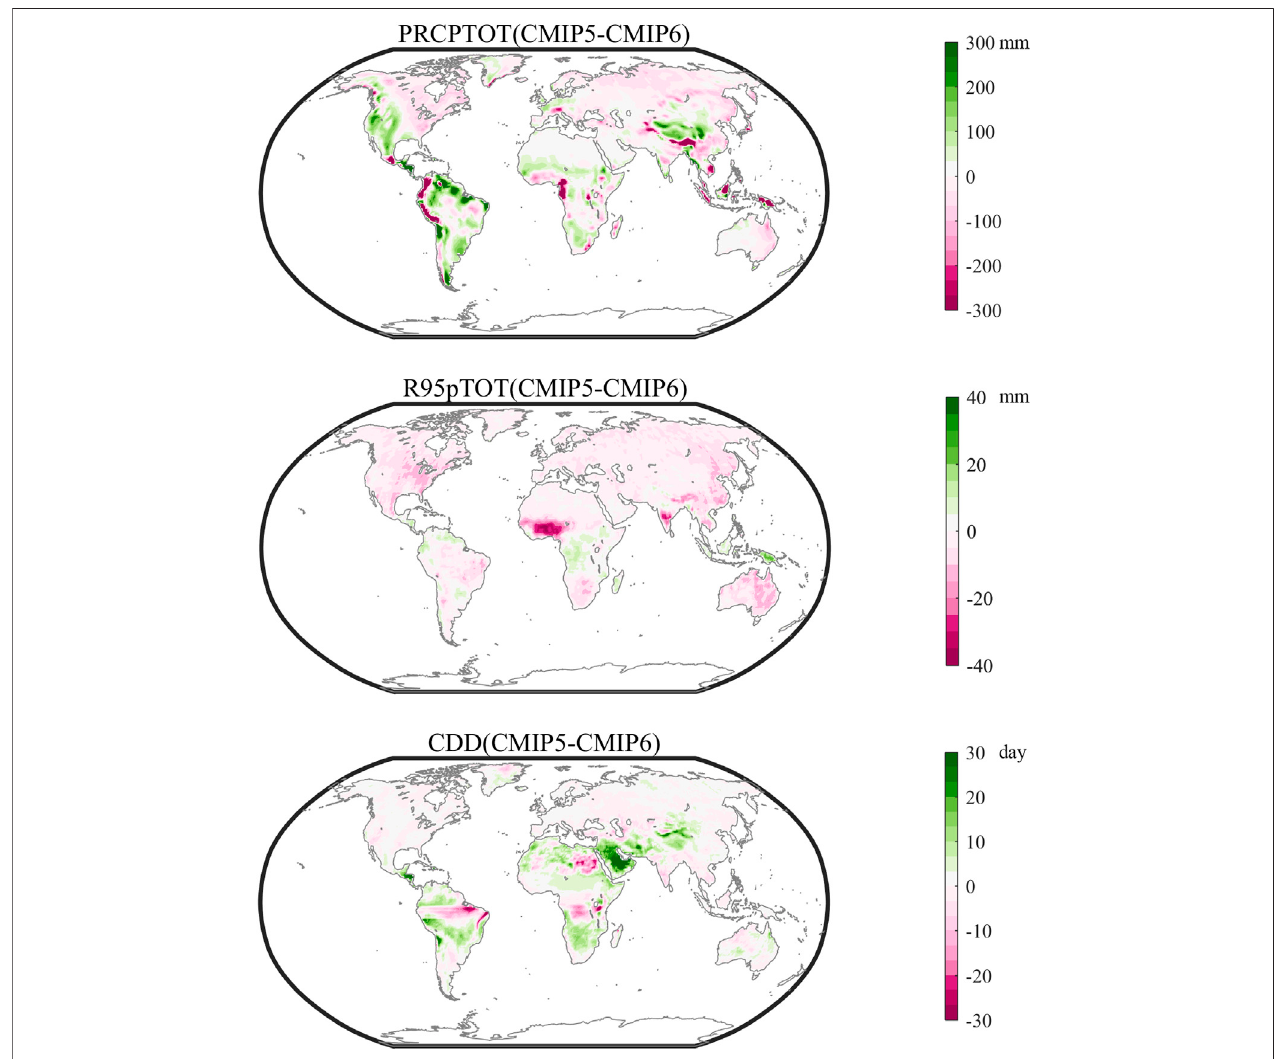
FIGURE 2 | Global distribution maps of root-mean-square error (RMSE) difference between CMIP5 and CMIP6. The multi-model mean RMSE of PCRPTOT, R95pTOT, CDD iscalculated based on the data in the historical period (1982 – 2005). When the RMSE of CMIP5 is bigger than that of CMIP6 (green color), itmeans that CMIP6 has better simulation performance than CMIP5. When the RMSE of CMIP5 is small than that of CMIP6 (red color), it means that CMIP6 has worse simulation performance than CMIP5.